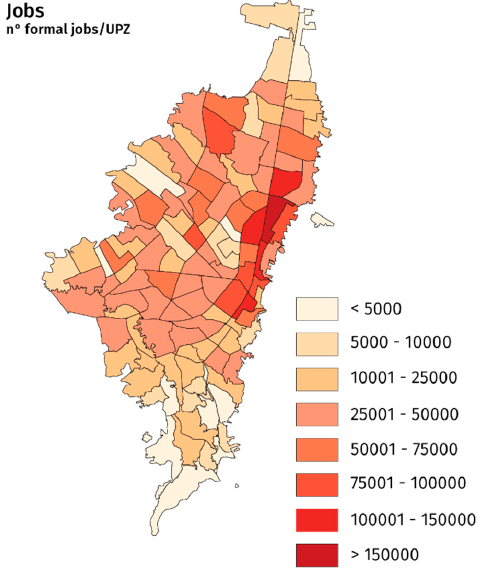
Figure 2. Job opportunities in Bogotá (source: [25).